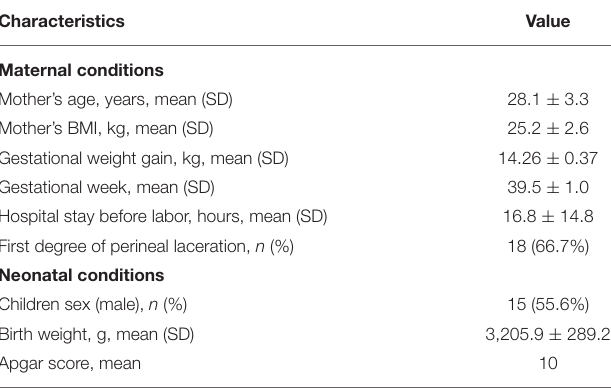
TABLE 1 | Demographic and clinical data for study participants.